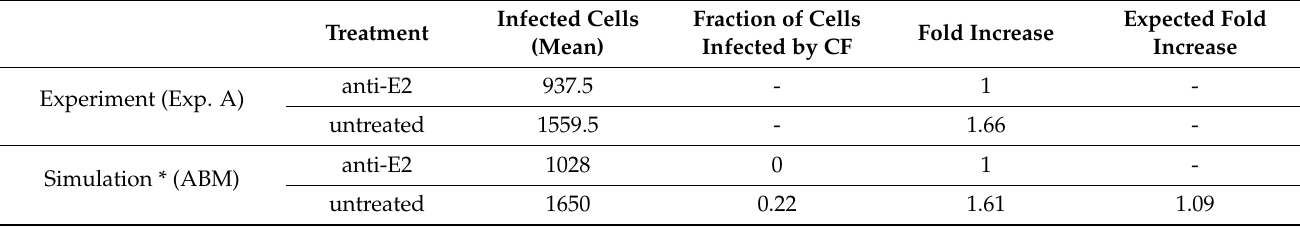
Table 2. Advantage of combined spread: Mean number of infected cells for experimental (Exp. A) and simulated data with and without anti-E2 treatment 120 h post inoculation. Experimental data allowing for both transmission modes show a 1.66-fold increase in infected cells compared to anti-E2 treated cultures. Similar results for simulated data using the parameterizations obtained for Exp. A with ~22% of infected cells due to cell-free transmission. Simulations show that the additive combination of infected cells by cell-free and cell-to-cell transmission would only lead to a ~10% increase in infected cell numbers compared to anti-E2 treated cultures. (* The results for the ABM show the average over 10 individual